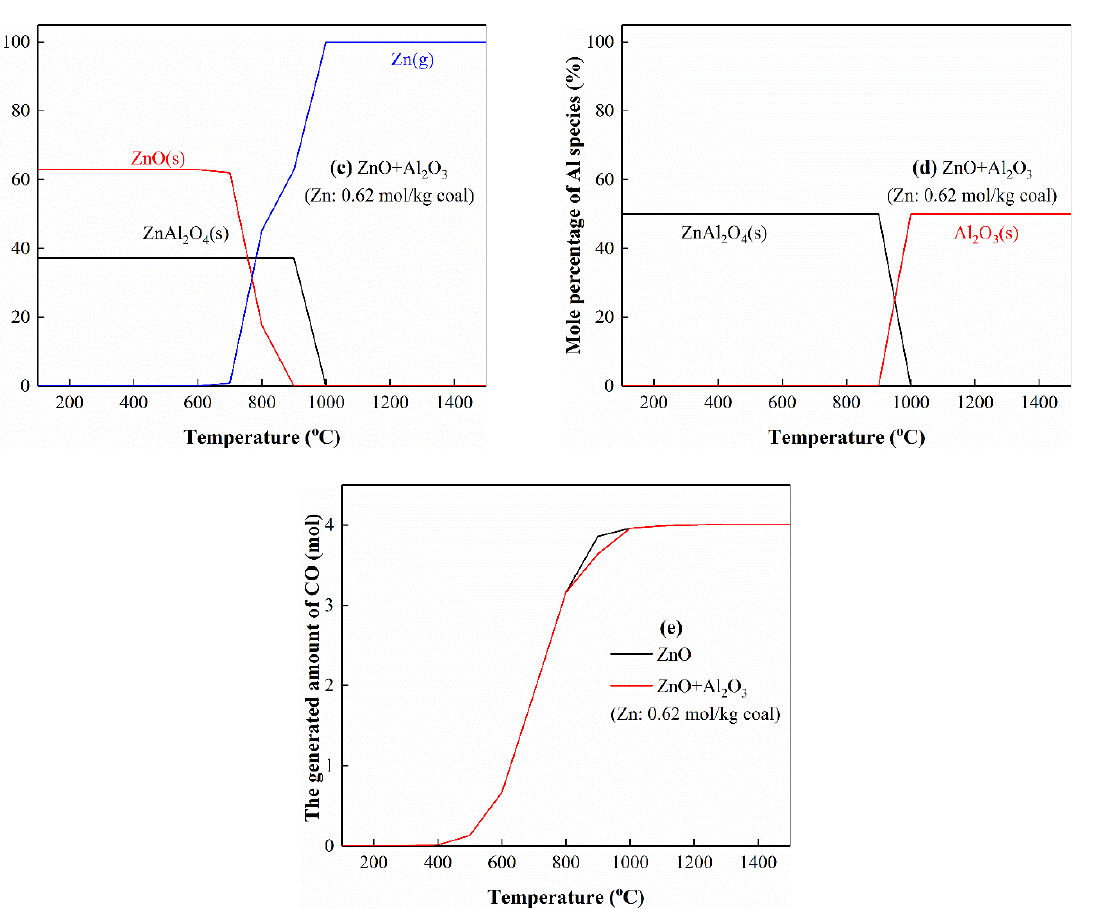
Figure 11. The thermodynamic equilibrium distributions of Zn ( a , c ), Al ( b , d ) and generated amount of CO ( e ) when Zn and Al coexist in the coal.